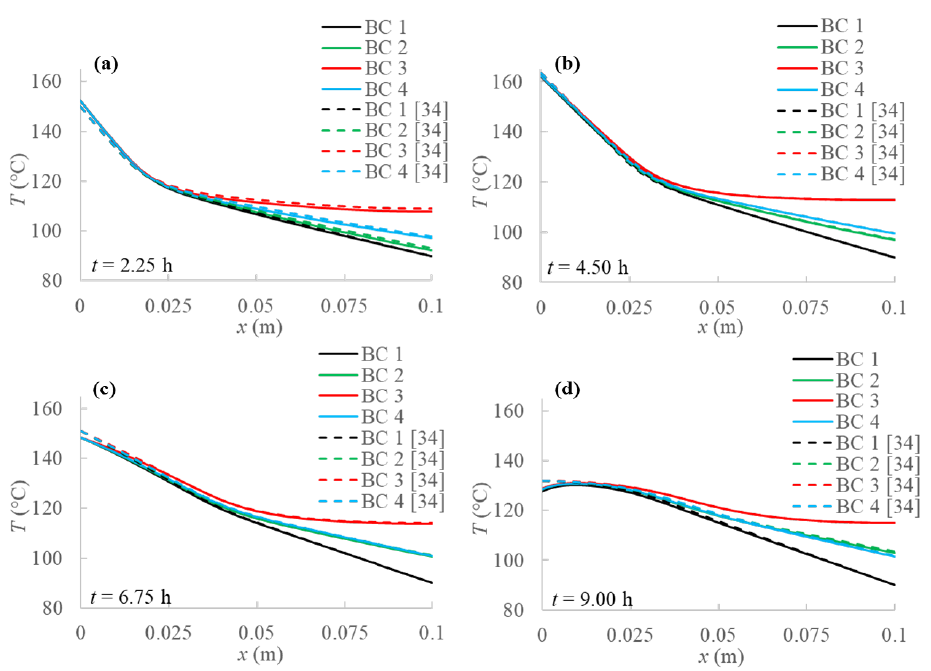
Figure 3. Comparison between temperature profiles for the 1D model [34] and the present 2D model without natural convection at different evaluation times: ( a ) after 2.25 h; ( b ) after 4.50 h; ( c ) after 6.75 h; ( d ) after 9.00 h from the simulation beginning respectively.